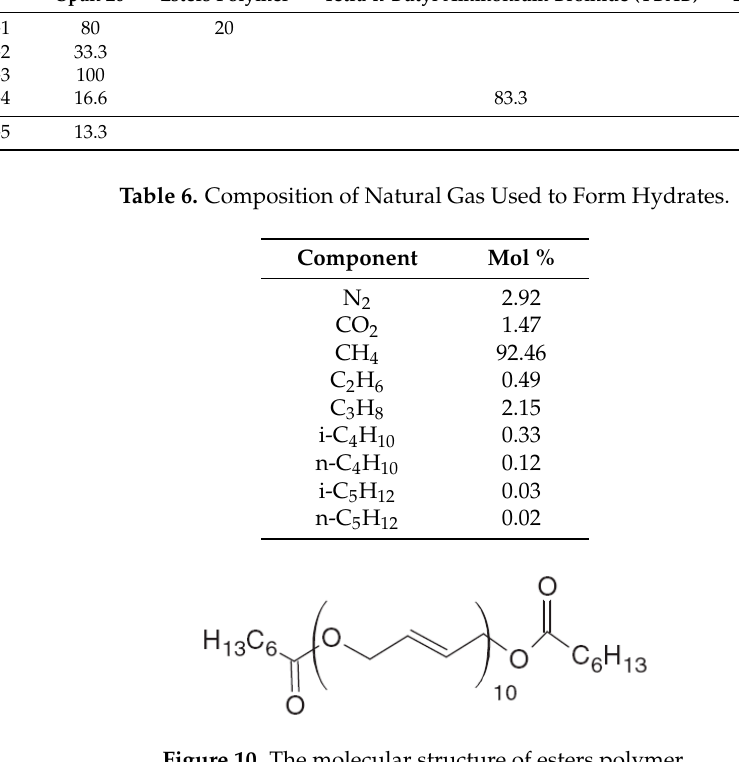
Table 5. Specification of tested AAs.